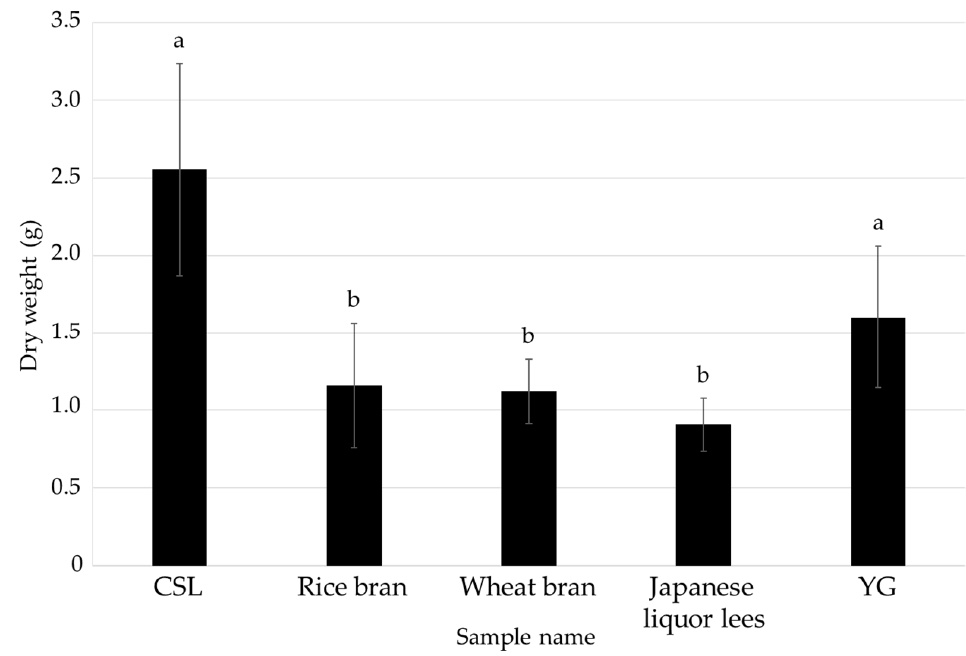
Figure 1. Effects of the media containing each of the food industrial by-products on the mycelial growth of L. sordida . The dry weight of the mycelia (the water-insoluble components) for each condition is shown. Different alphabet letters indicate significant differences (Tukey–Kramer post hoc test, p < 0.05; n = 3).